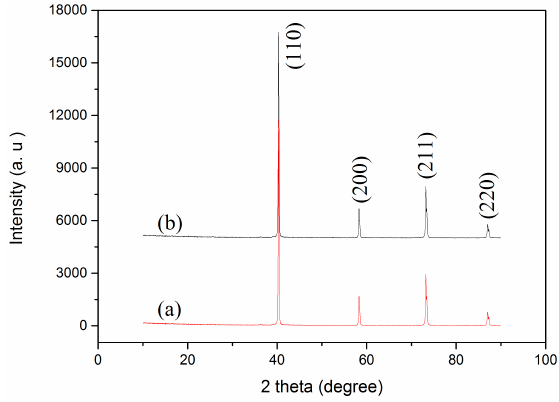
Figure 6. X-ray powder diffraction (XRD) patterns of ( a ) W–1 wt % Nd 2 O 3 ; ( b ) W–1 wt % CeO 2 composites sintered by SPS.